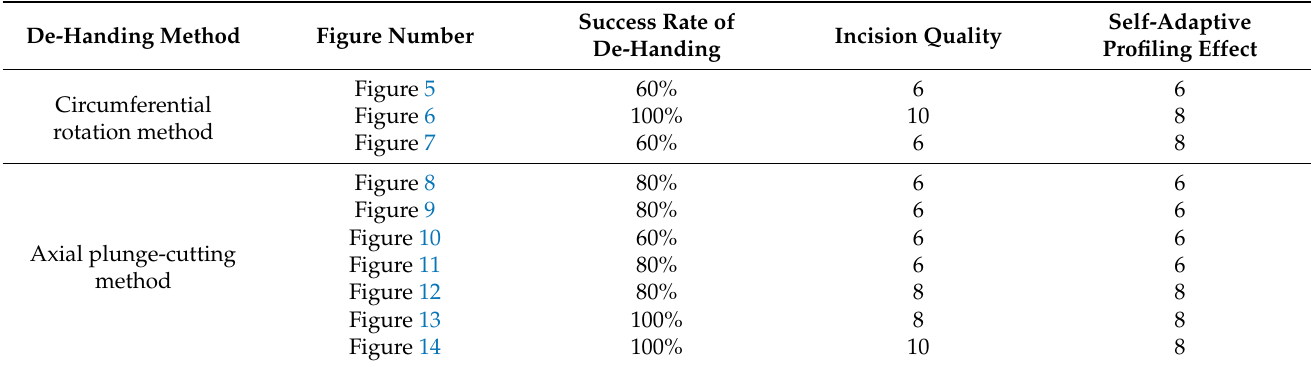
Table 1. Performance measures for various mechanical de-handing technology and equipment reviewed in this